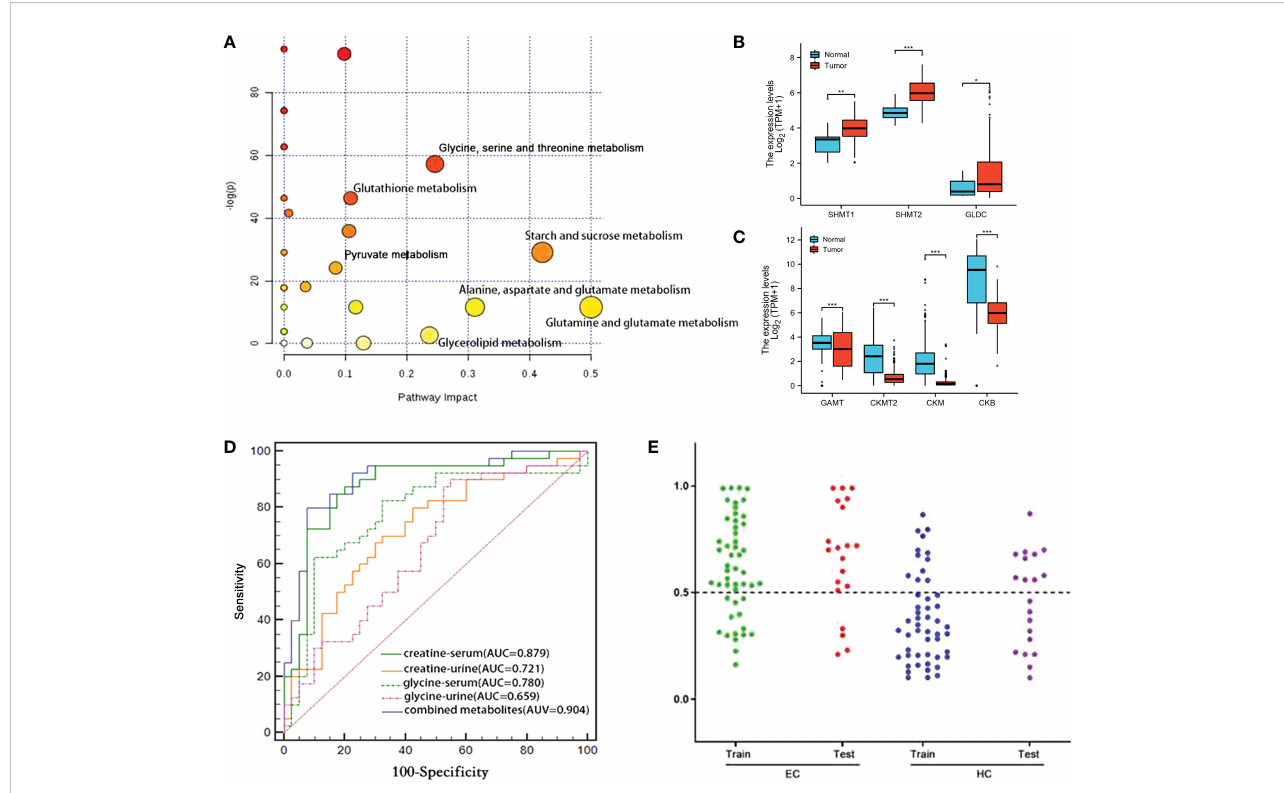
FIGURE 4 (A) Metabolic pathways associated with various metabolic alterations in ESCC vs. HCs. (B, C) Comparison of the metabolic enzyme gene expression related to “ glycine, serine and threonine metabolism ” between ESCC cancer tissues and normal tissues (ns, p ≥ 0.05; *, p< 0.05; **, p<0.01; ***, p<0.001). (D) Comparison of the ROC curves used for distinguishing ESCC patients from HCs, based on the levels of various individual serum and urine metabolites and a combined set of metabolites. (E) Prediction and validation of the diagnostic accuracy of the optimal combined biomarker panel for ESCC detection ( “ training set ” : ESCC=50, HC=50; “ discovery set ” : ESCC=20, HC=20). ns, not statistically signi fi